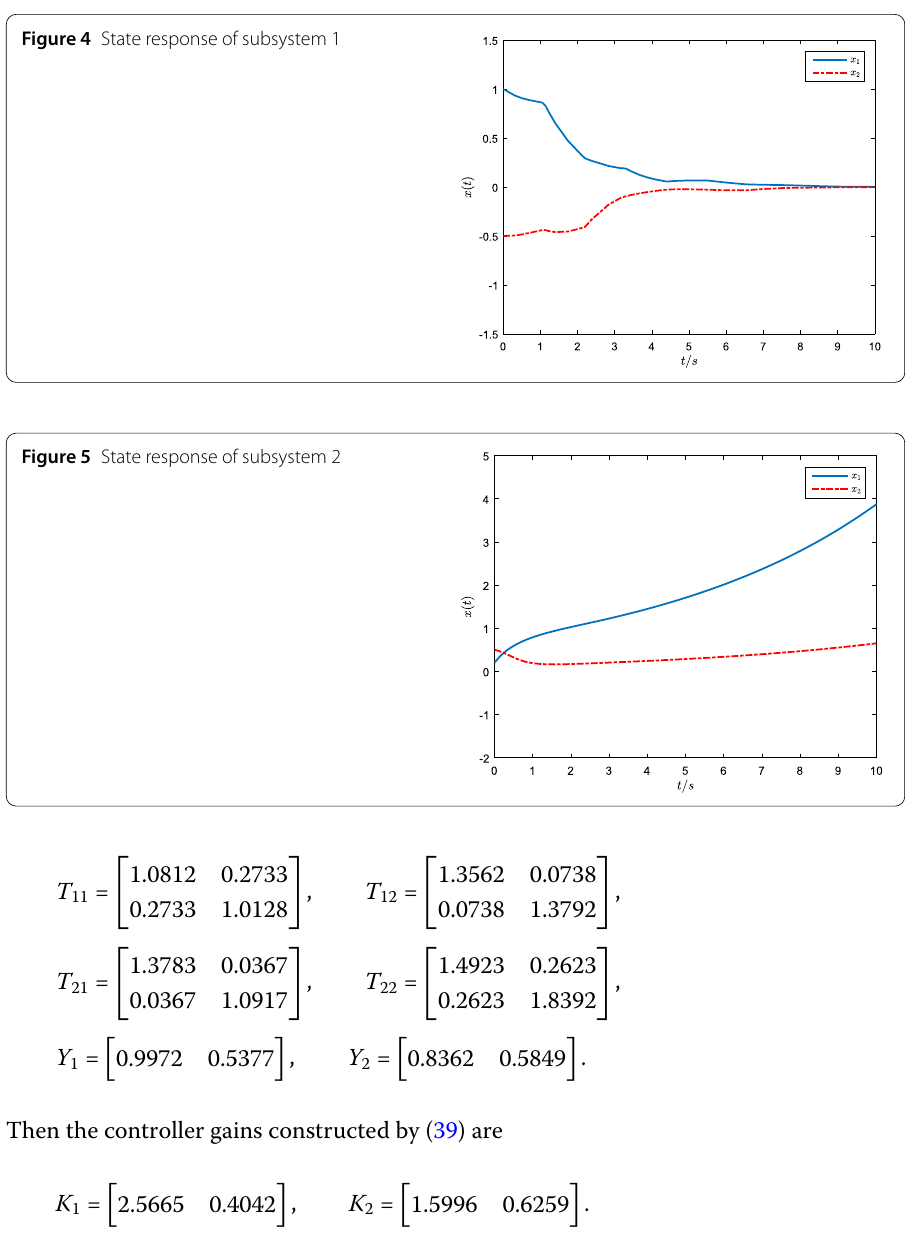
Figure 4 State response of subsystem 1